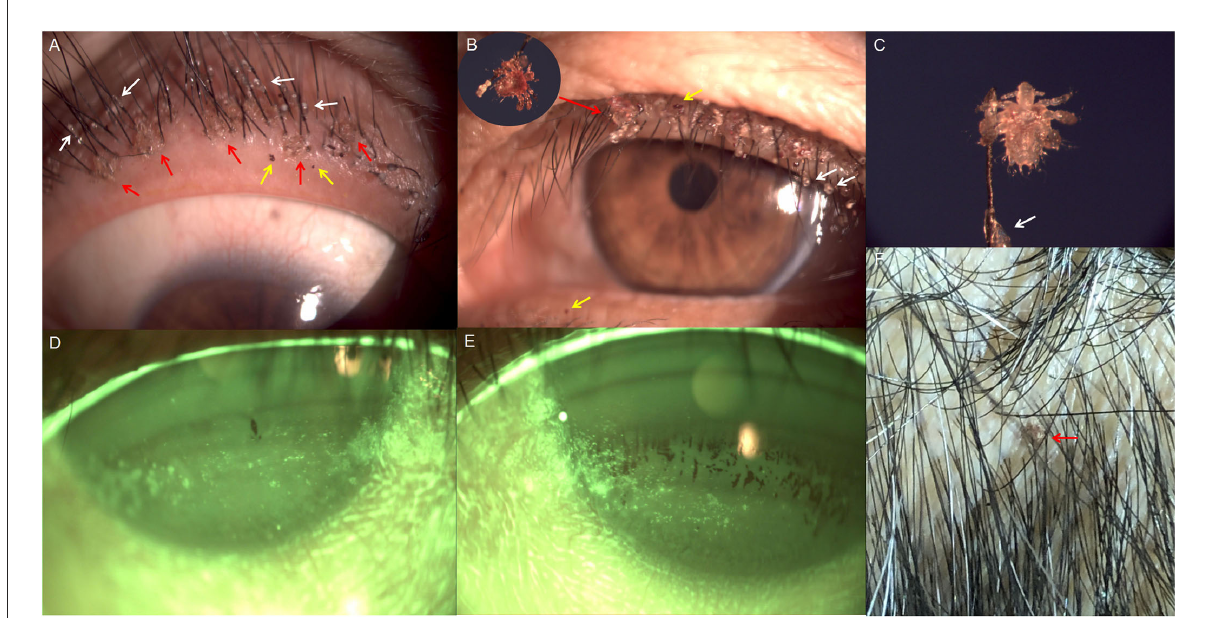
FIGURE1 Slit-lamp photographs of both eyes and smartphone photograph of the scalp at the initial examination. (A,B) Lice (red arrows) and fecal matter (yellow arrows) on the lid margin of both eyes; numerous nits firmly stuck to the eyelashes (white arrows). (C) Crab-like louse grasping the eyelash (40 × magnification); translucent nit adhering to the eyelash (white arrow). (D) Corneal epithelial defects of right eye. (E) Corneal epithelial defects of left eye. (F) Louse (red arrow) on the